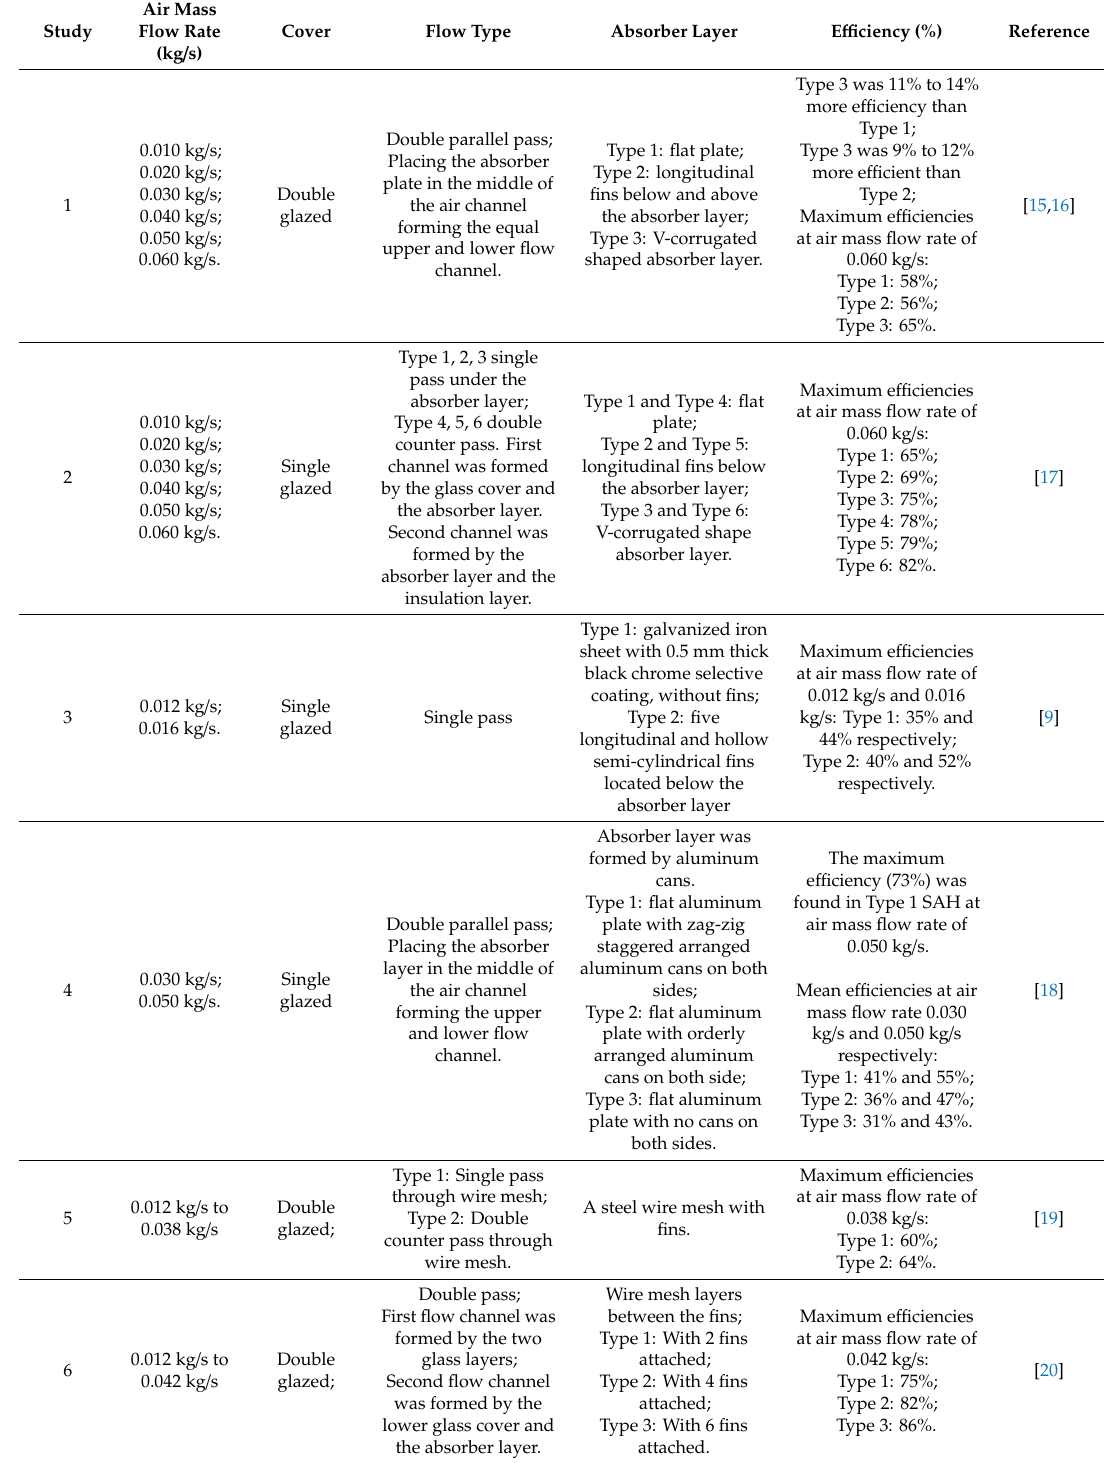
Table 1. E ffi ciencies of several types of solar air heater operated at di ff erent air mass flow rate.